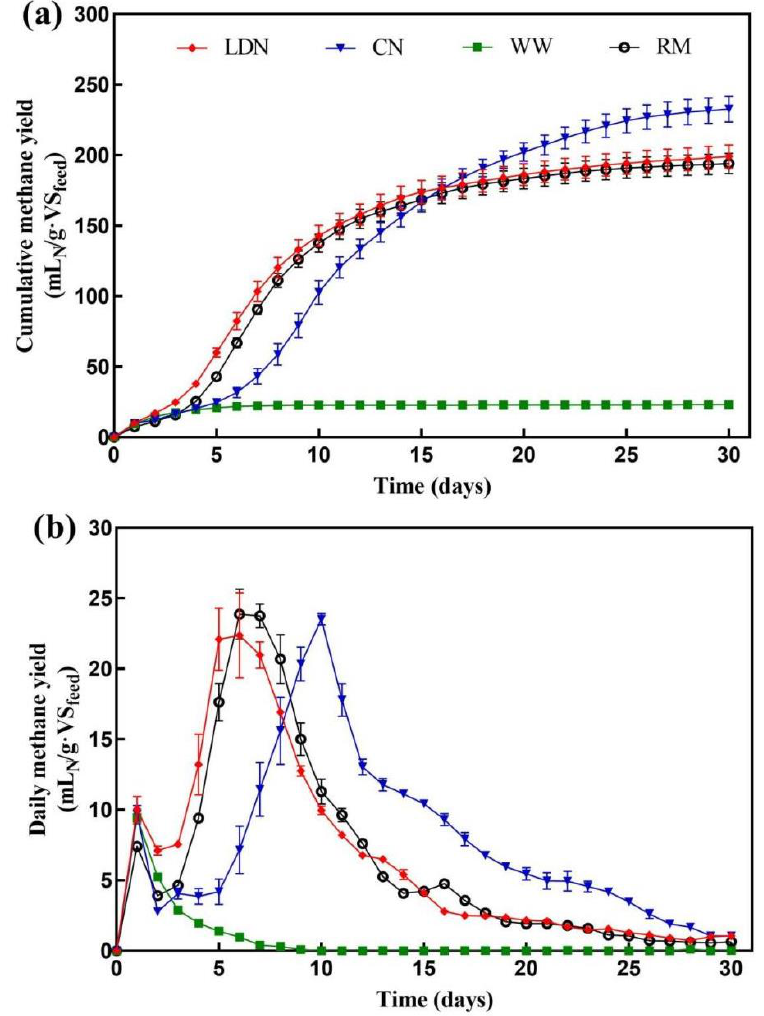
Figure 4. Effect of different neutralization treatments on the ( a ) cumulative methane yield; and ( b ) daily methane yield during 30 days thermophilic SS-AD of lime-treated corn stover. Data are shown as mean ± SD, n = 3.